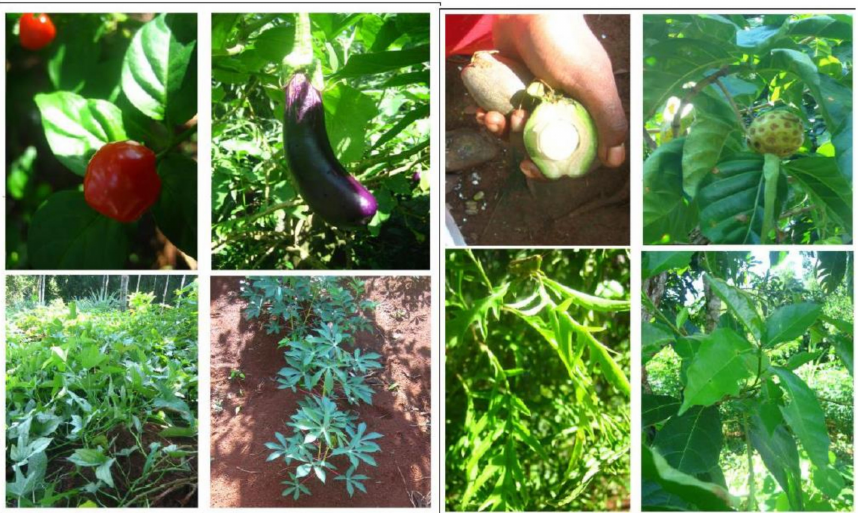
Figure 6. Melanesian gardens are constructed across diverse settings, both close to the village and far away. Villagers construct paths to access gardens that can contain a wide variety of food crops. This research has demonstrated the link between cultural traditions and community resilience with respect to disasters. In this case the communities which had strong agricultural traditions, including cropping of diverse locations and food plants, alongside longer-term food storage knowledge and an ability to apply a range of cooking techniques, were the more resilient communities with respect to disasters and post-disaster adaptation.